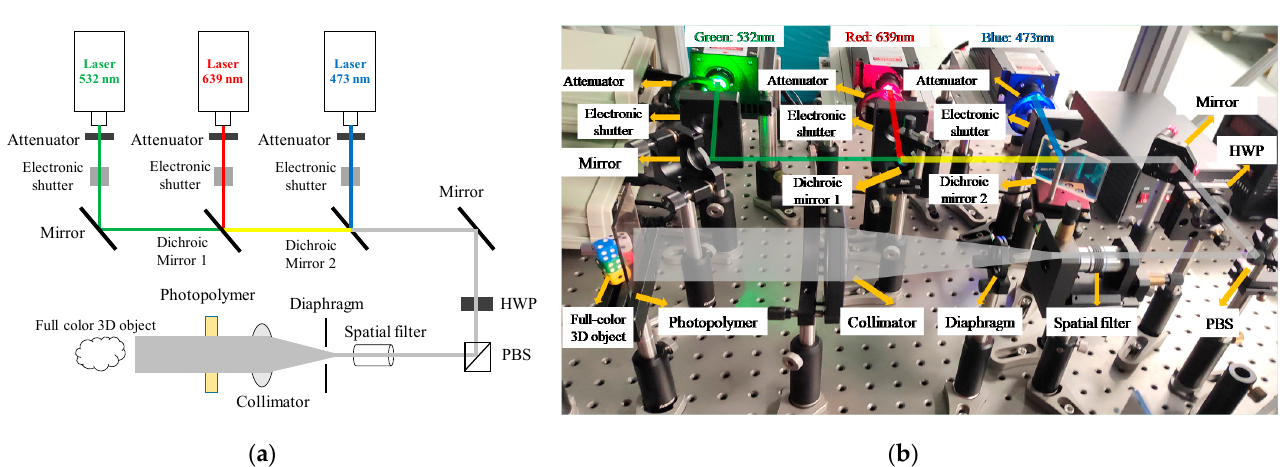
Figure 8. Construction of the RGB multiplexing optical setup: ( a ) schematic diagram of the interference optical setup; ( b ) physical diagram of the interference optical setup.